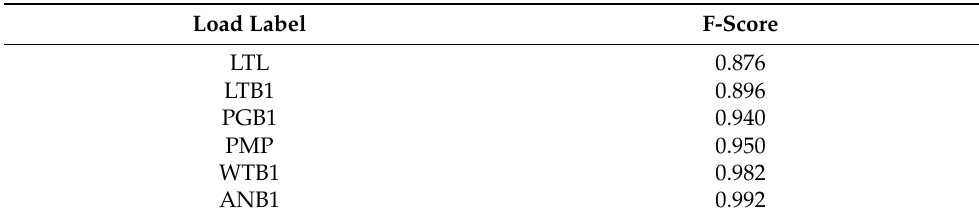
Table 5. Power states identification performance by F-score based on the MTC